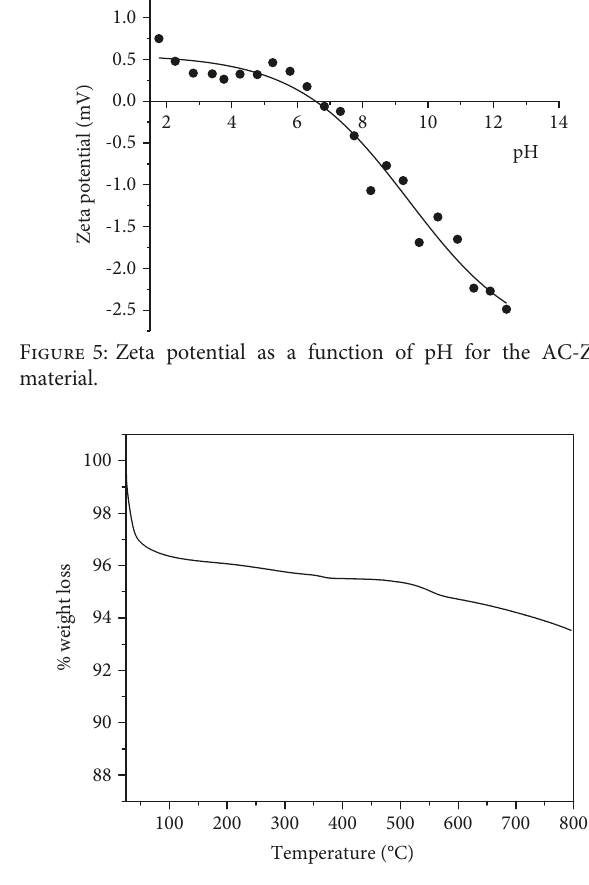
Figure 6: TGA analysis of the AC-ZnO